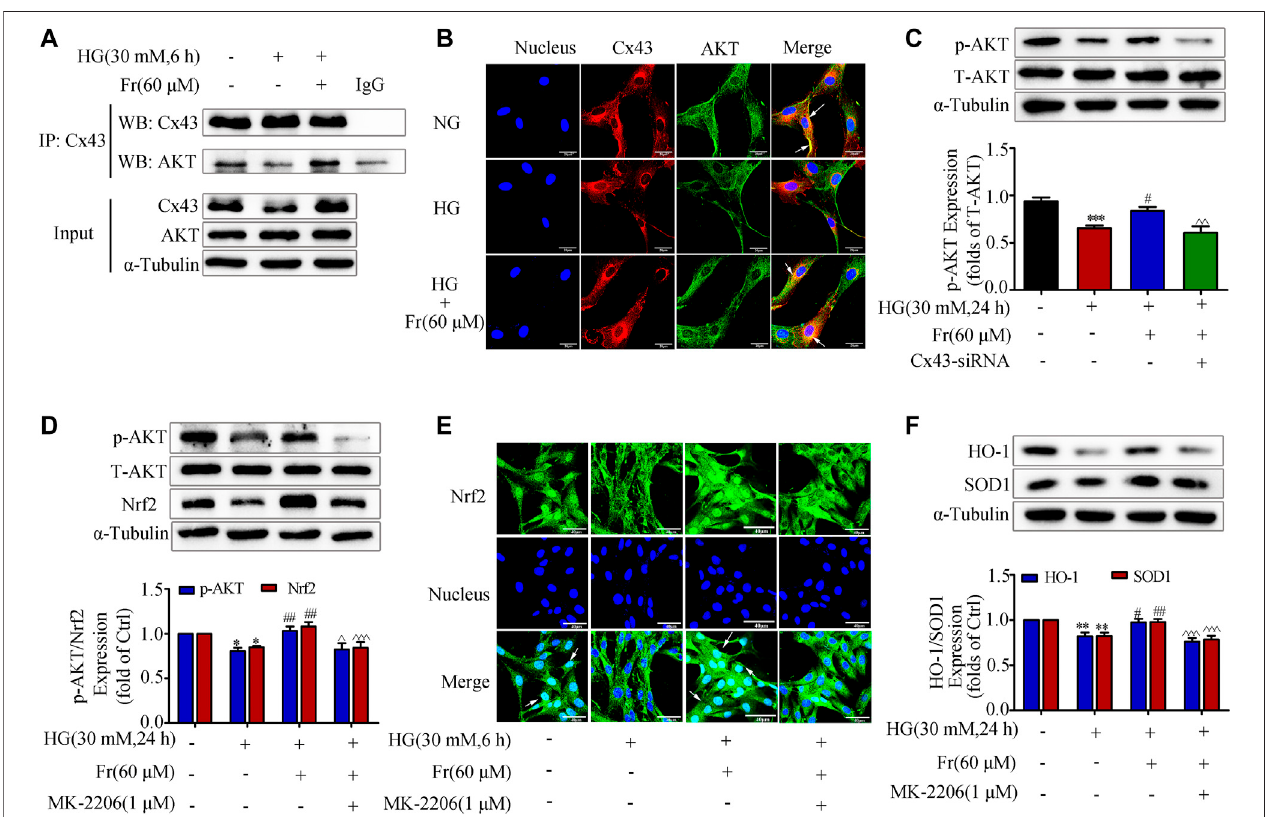
FIGURE 5 | Fr promoted the activation of Nrf2/ARE pathway by regulating the interaction between Cx43 and AKT. (A) Immunoprecipitation results of Cx43 suggested that Cx43 interacted with AKT. (B) IF results showed that AKT and Cx43 co-localized in the cytoplasm of the GMCs (1000× magni fi cation). Green fl uorescenceindicatedlocalizationofAKTandred fl uorescenceindicatedlocalizationofCx43.Bar:20 μ m. (C) Theexpressionofp-AKTweretreatedwithCx43-siRNAin GMCs. (D) The western blot analysis of the p-AKT and Nrf2in GMCs was treated with MK-2206 and/or Fr. (E) The subcellular distribution of Nrf2 in GMCs was measured by immuno fl uorescent staining (×600 magni fi cation). Bar: 40 μ m. Green fl uorescence indicated localization of Nrf2. (F) The western blot analysis of the HO-1 and SOD1 in GMCs was treated with MK-2206 and/or Fr. * p < 0.05, ** p < 0.01, *** p < 0.001 vs . Ctrl; # p < 0.05, ## p < 0.01, ### p < 0.001 vs . HG; ^ p < 0.05, ^^ p < 0.01, ^^^ p < 0.001 vs . HG with Fr. Independent experiments are performed at least three times with similar